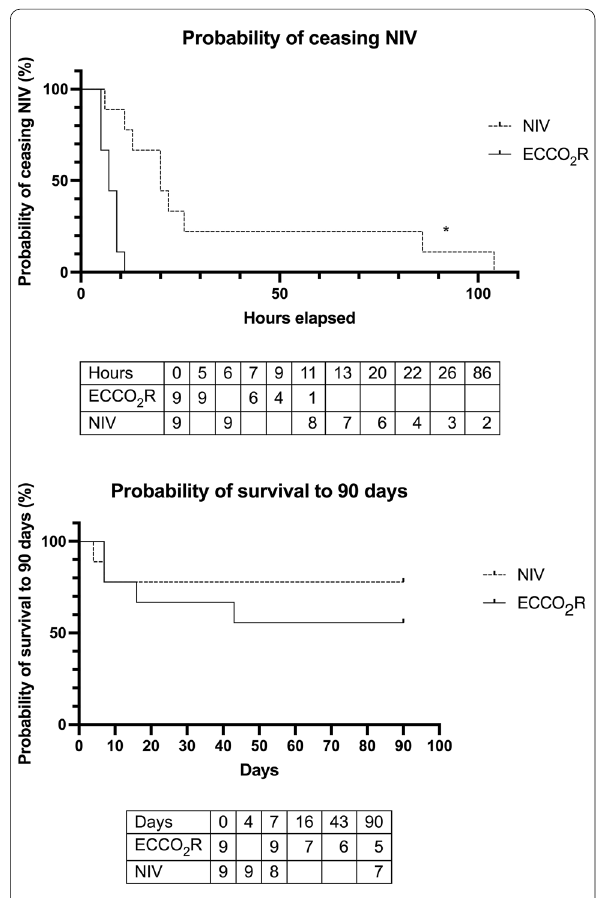
Fig. 3. a Probability of remaining on NIV over time; b probability of survival to 90 days